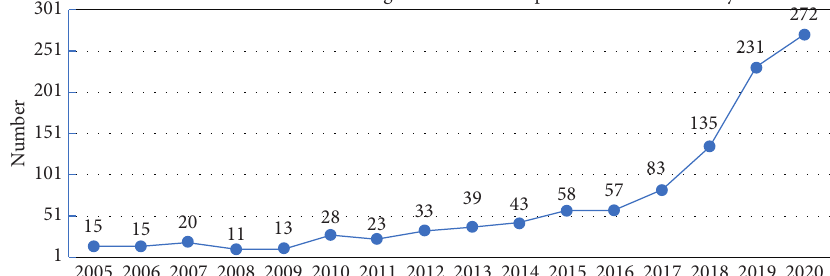
Figure 3: Number of autonomous driving articles published in 2005–2020 years.